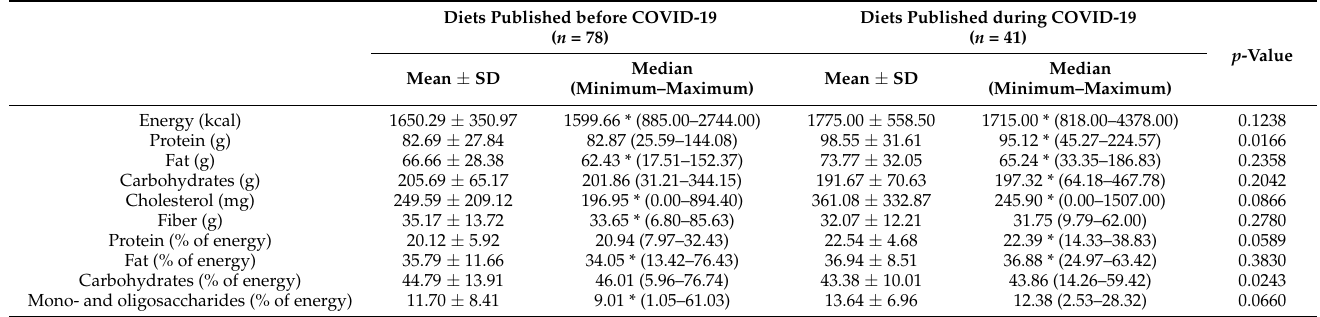
Table 4. The energy value and macronutrient intake within the assessed single-day menus, stratified by year of publication, for the diets published before the COVID-19 pandemic and the diets published during the COVID-19